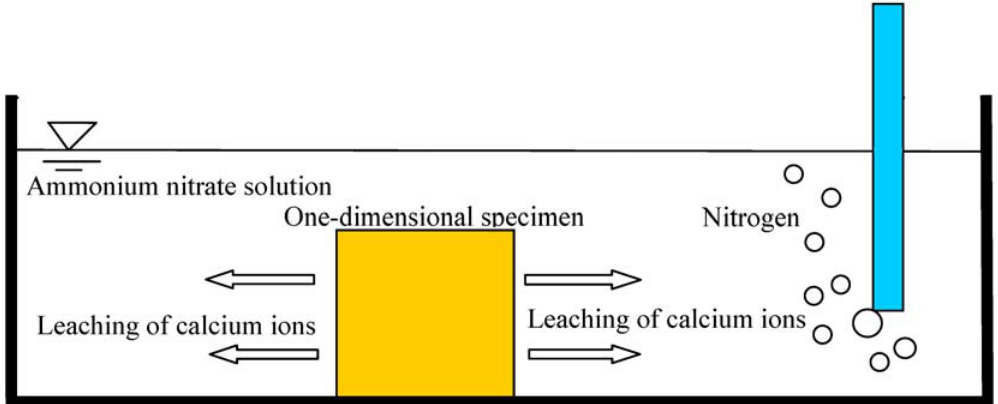
Figure 1. Scheme describing the accelerated leaching protocol using ammonium nitrate